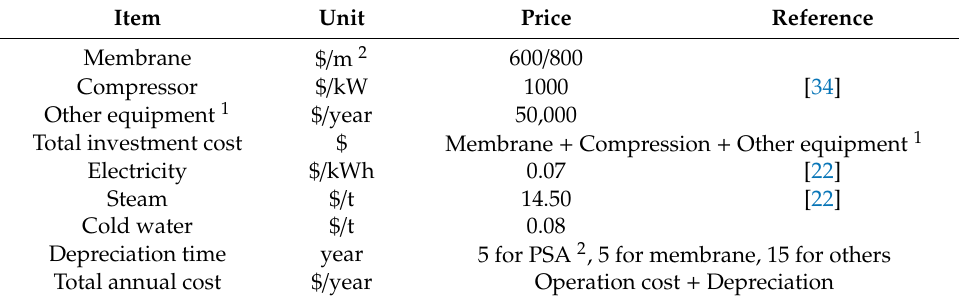
Table 3. Cost parameters for economic assessment .